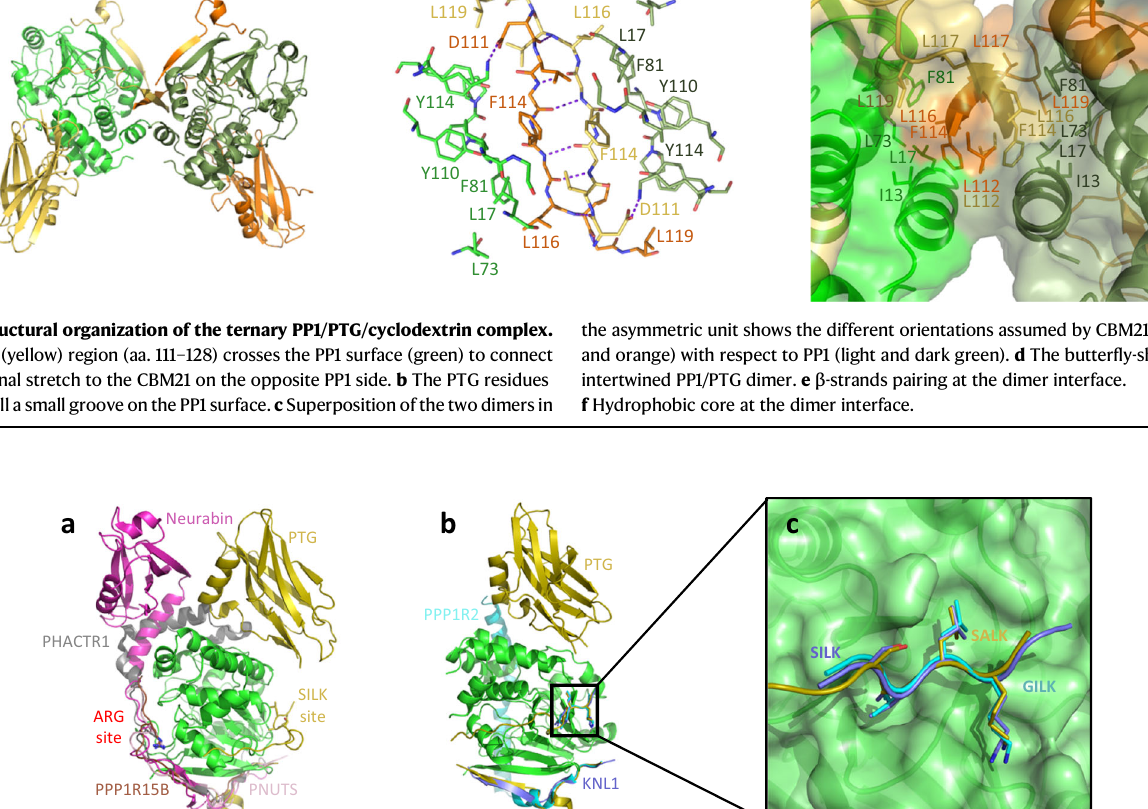
totheARGsiteintheotherproteins. b SuperpositionofPP1(green)incomplexwith PTG (yellow), KNL1 (purple), and PPP1R2 (cyan). c The SILK region in the three proteins perfectly superposes (color code same as above).